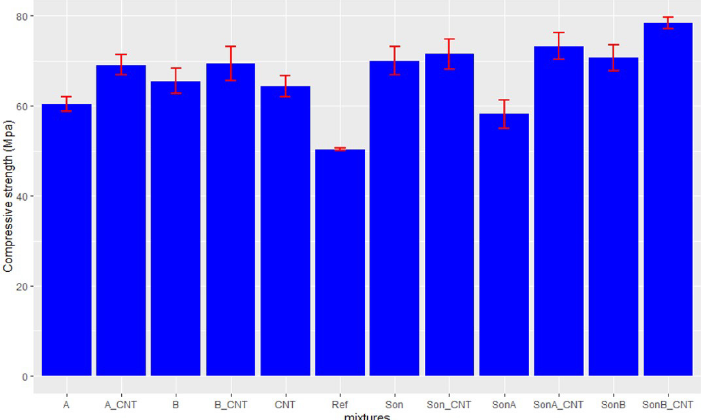
Figure 10. Compressive strength of the hardened Portland cement